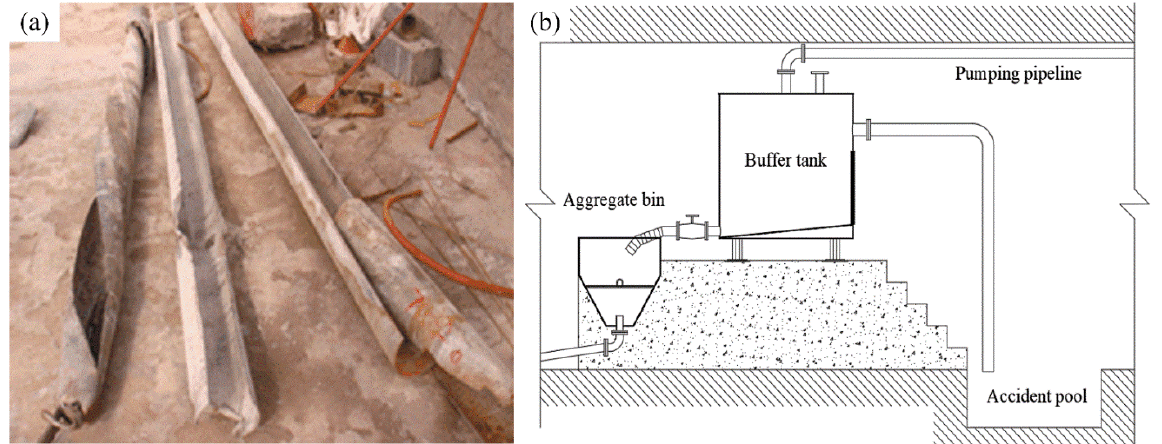
Figure 4. Pumping system: ( a ) cavitation and erosion; ( b ) pressure relief device configuration drawing.